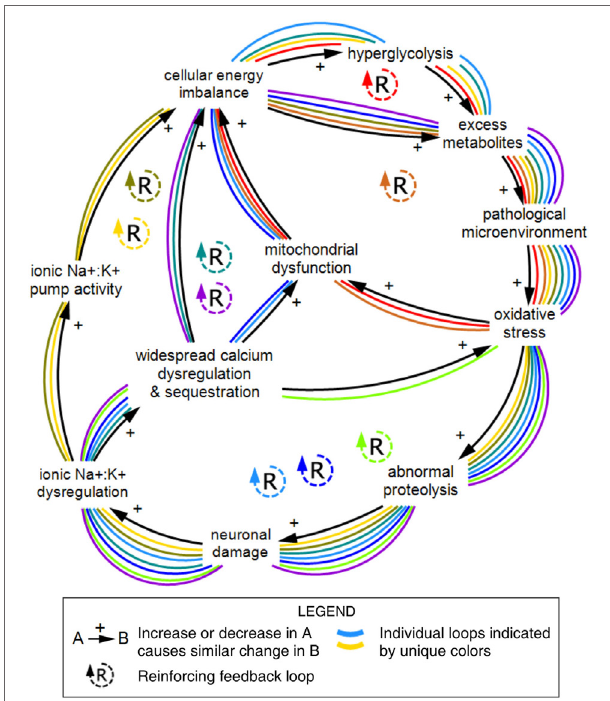
FigUre 5 | Nine feedback loops within the cellular scale of concussion. A series of reinforcing loops across the metabolic, ionic, and neuronal subsystems demonstrate the large number of feedback relationships that emerge from connections between a relatively small number of variables. The reinforcing structure of these relationships indicates compounding effects over time. Individual feedback loops are marked with unique colors. Diagram rendered in